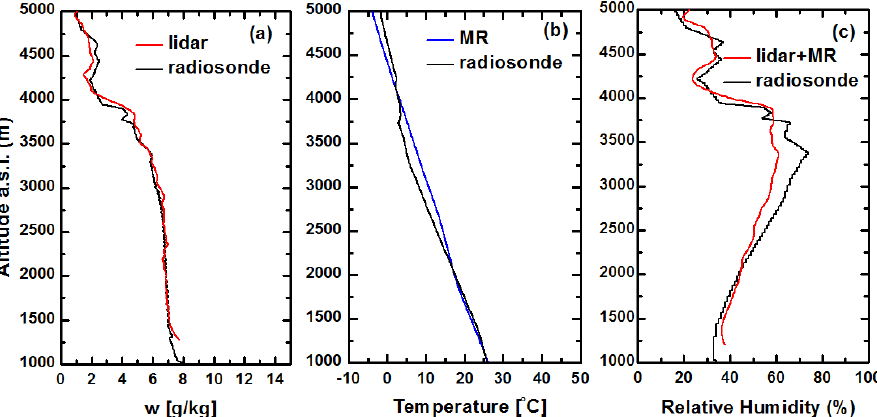
Fig. 4. Night-time measurements performed on 25 July 2011. (a) Water vapour mixing ratio profiles retrieved from Raman lidar and ra- diosonde, (b) temperature profiles from microwave radiometer and radiosonde, and (c) RH profile obtained from Raman lidar and microwave radiometer (MR) and from radiosonde.